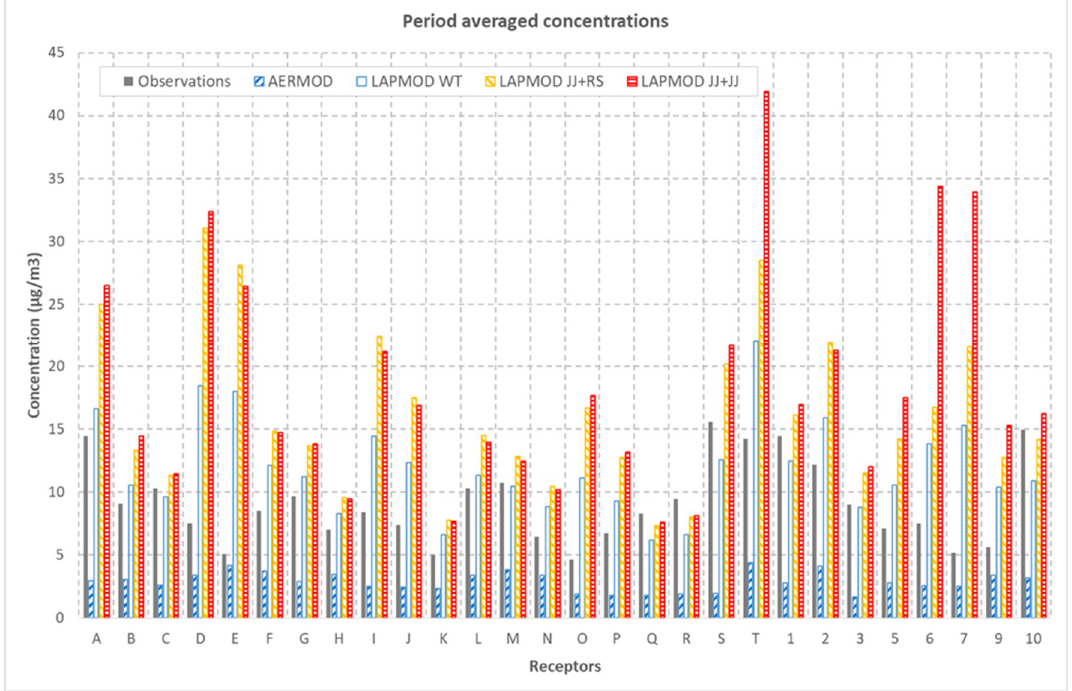
Figure 10. Period averaged concentrations for observations, AERMOD, and LAPMOD predictions.